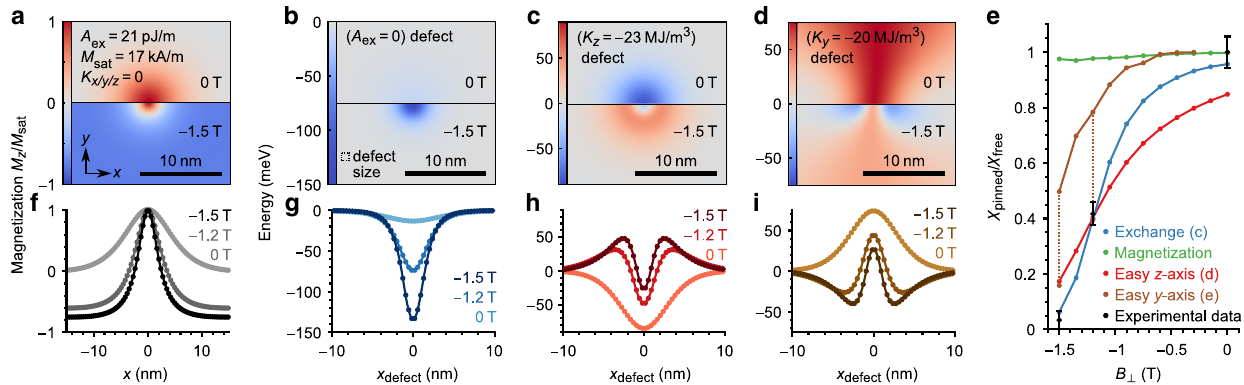
Fig. 3 Micromagnetic simulation of pinning potentials. a Scaled, perpendicular magnetization m z = M z / M sat of a simulated vortex core in a disk of height 10 nm and diameter 280 nm at B ⊥ = 0 T (upper half) and B ⊥ = − 1.5 T (lower half) with magnetic parameters indicated. b – d Defect potentials for vortex core in meV at different types of magnetic defects, where only the marked parameters are changed with respect to a within a central area at the surface of 1.1 × 1.1 × 0.5 nm 3 (3 × 3 × 1 cells). The display type is as in a . The spatial dependency of the vortex energy is simulated by scanning the defect through